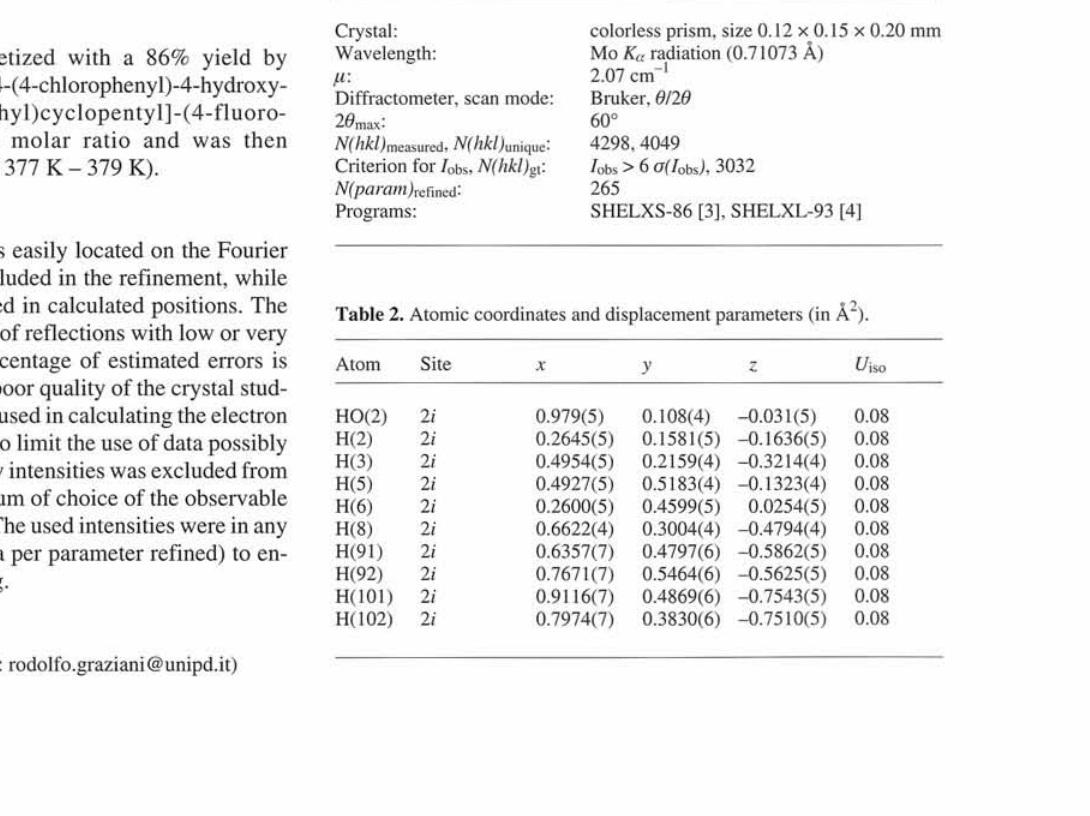
Table 1. Data collection and handling.